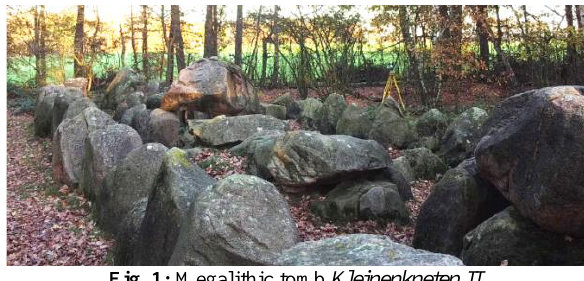
Fig. 1: Megalithic tomb Kleinenkneten